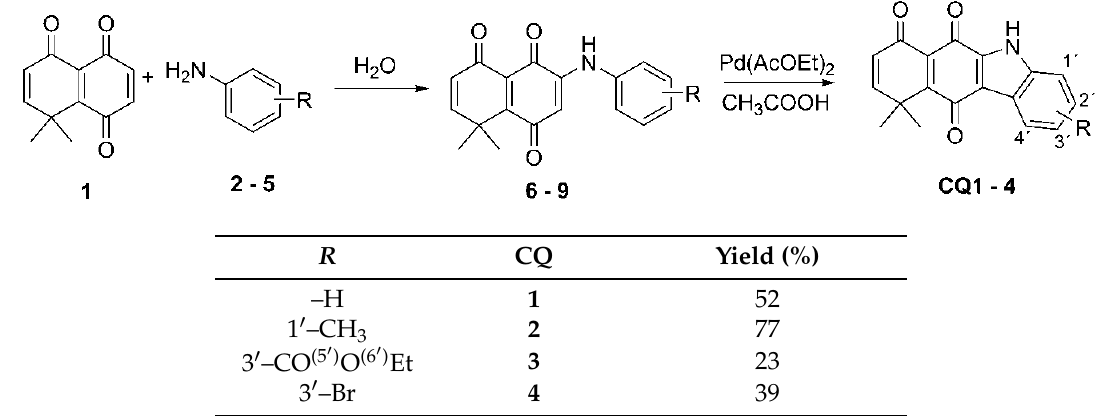
Figure 2. Synthetic route to obtain o -carbonylcarbazolquinones CQ1 to CQ4 .